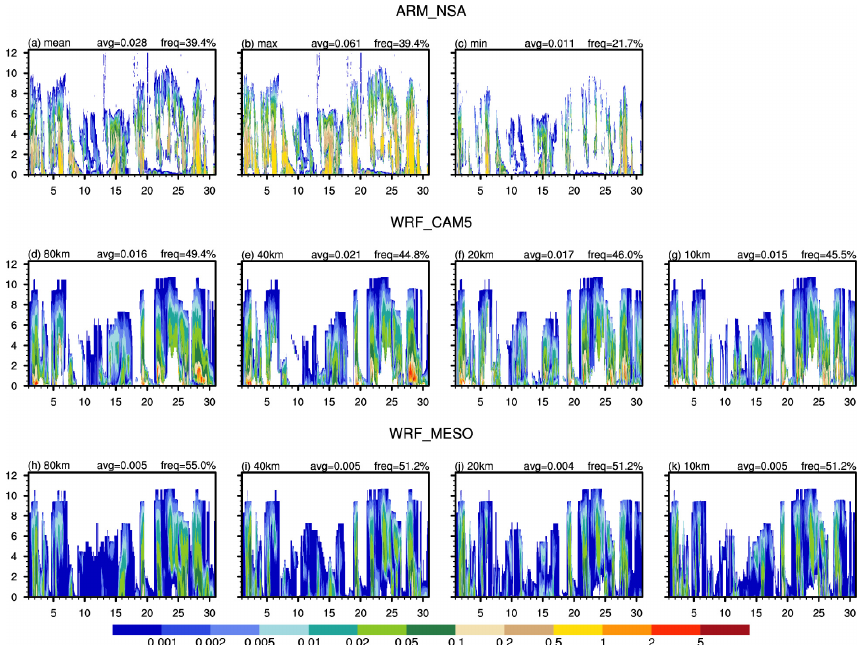
Fig. 17. Time series of vertical profiles of ice water content (gkg − 1 ) from ARM: (a) hourly mean, (b) hourly maximum, and (c) hourly minimum, compared with the in-cloud ice water content (gkg − 1 ) from (d) – (g) WRF_CAM5 and (h) – (k) WRF_MESO simulations at Barrow. Values of average ice water content and frequency of occurrence of ice cloud are given.